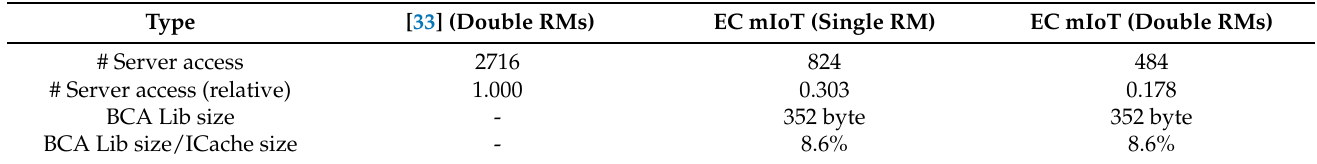
Table 2. Edge-centric mIoT platform experiment results.